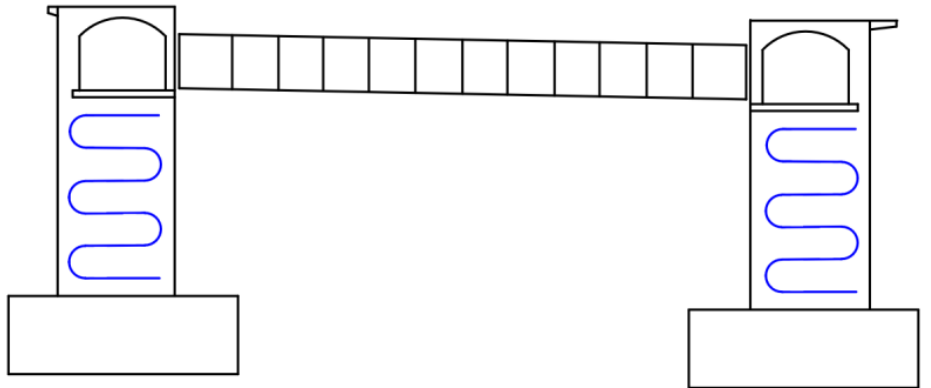
Figure 7. Cooling pipe layout of main pier.